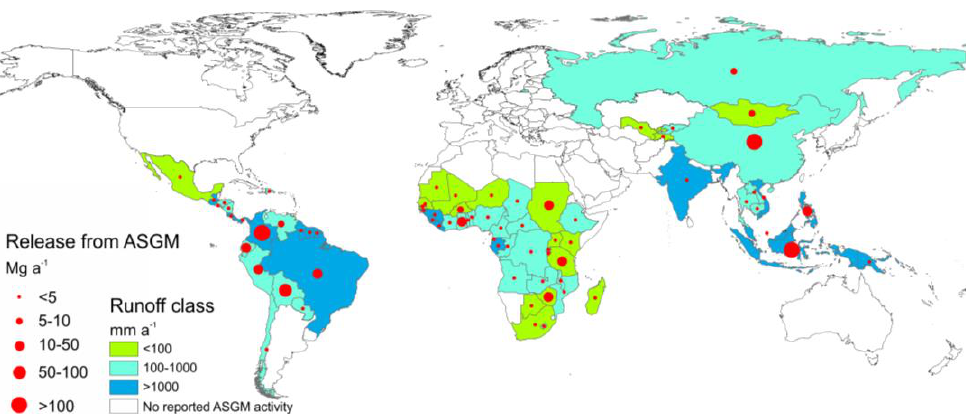
Figure 3. Estimated releases of Hg from artisanal and small-scale gold mining (ASGM) to terrestrial systems (land and water) and surface runoff class [30] for countries with known ASGM activities.